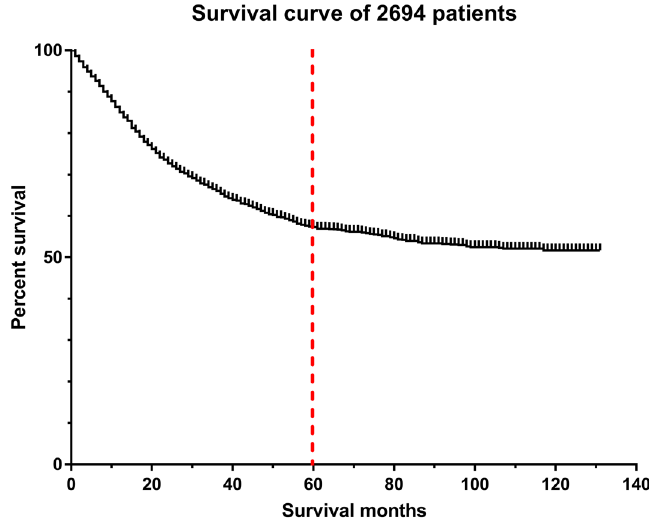
Figure 1. Overall survival curve for the 2694 osteosarcoma patients from the Surveillance, Epidemiology, and End Results (SEER) program database (2004–2014). The red line is the 5-year cut-off. The figure was created by using GraphPad Prism 7 (https ://www.graph